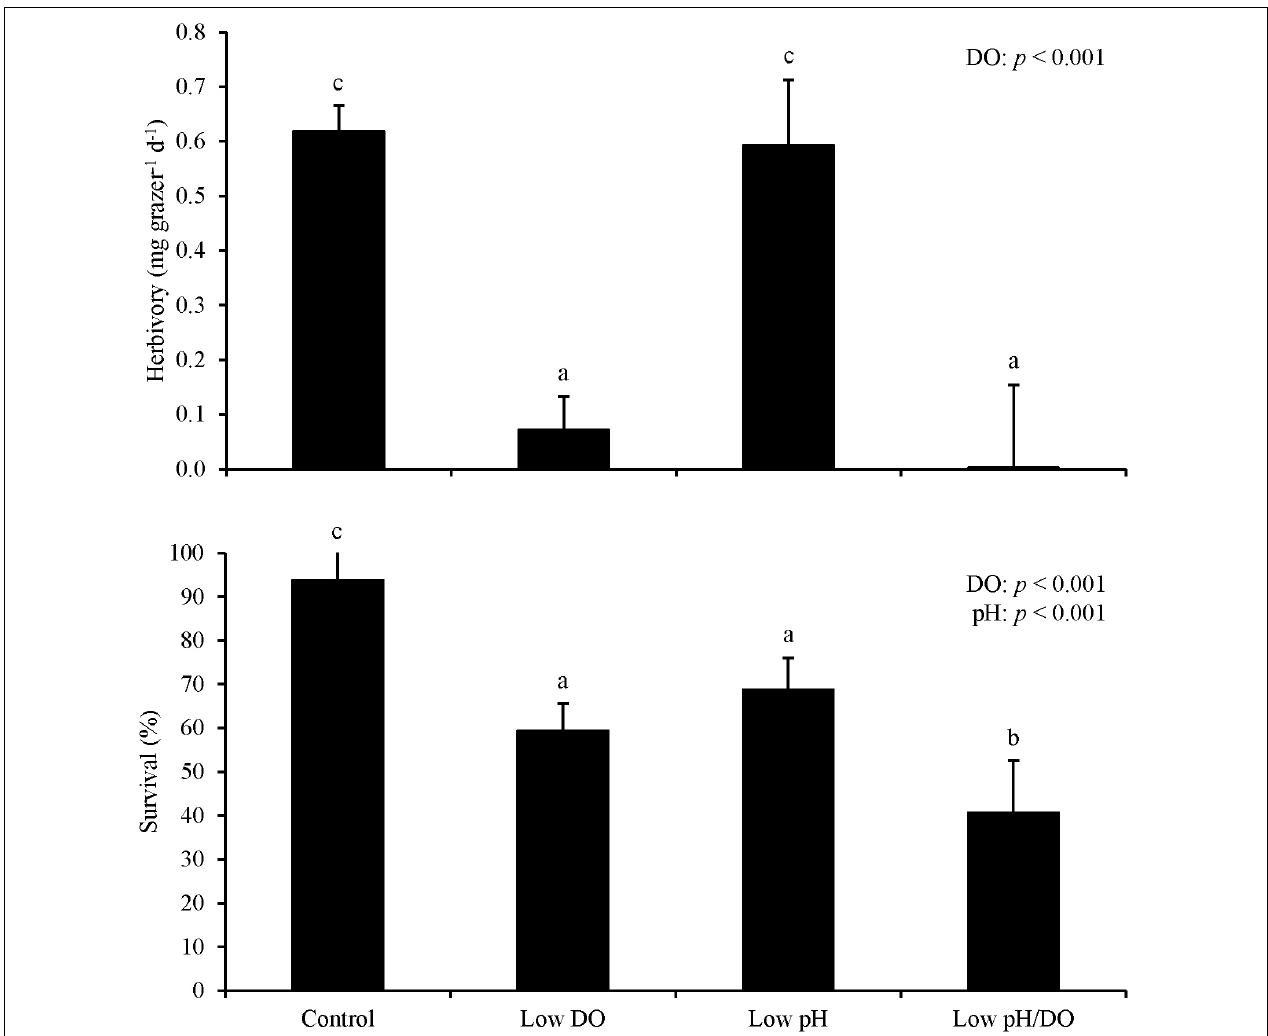
FIGURE 2 | Herbivory rates and survival of L. vincta grazing on U . rigida without initial starvation under control (ambient pH/DO), low DO, low pH, and low pH/DO (Experiment 2; Table 2 ). Columns represent means ± standard deviation. Statistical analyses: Two-way ANOVA and post-hoc Tukey Honest Significant Difference tests performed; significant differences between treatments represent p -values less than